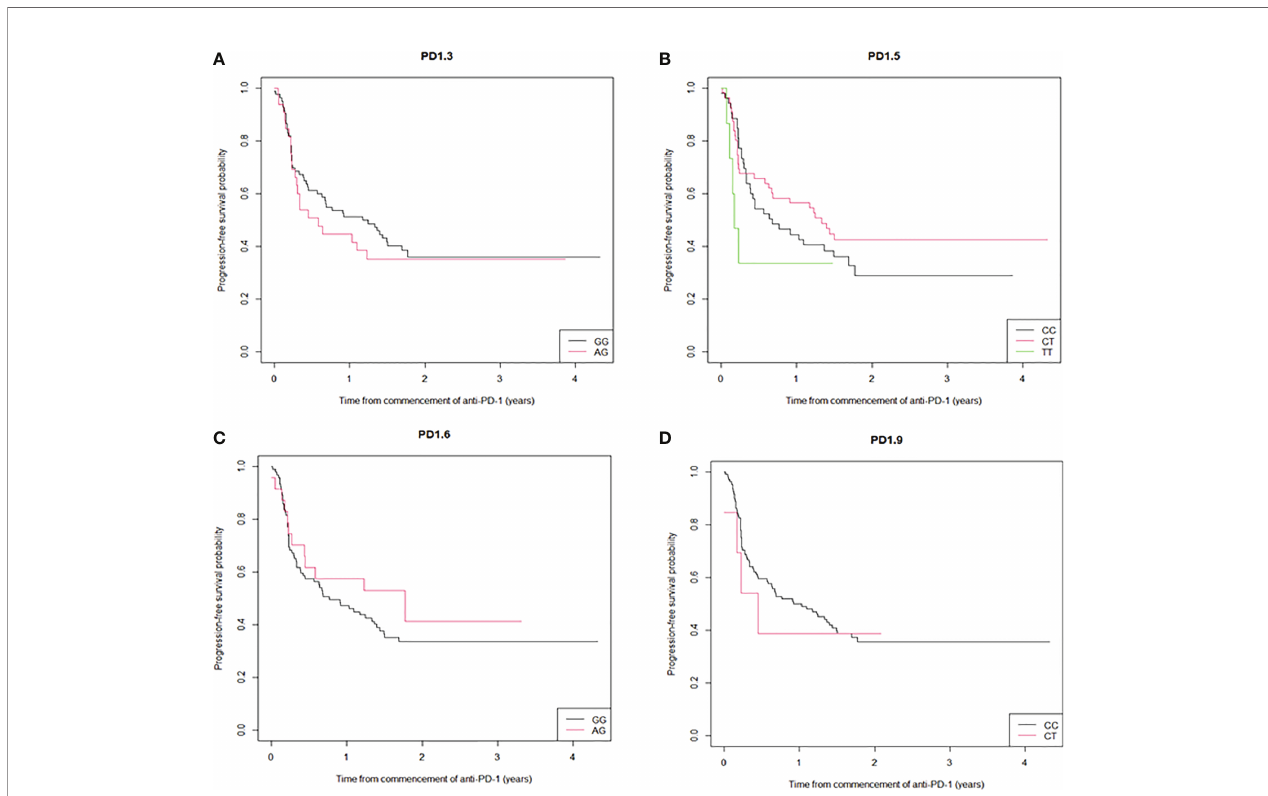
FIGURE 2 | Kaplan-Meier curves of progression-free survival strati fi ed by the individual SNPs. (A) the median PFS for PD1.3 rs11568821 GG allele was 14.1 months versus 7.0 months for the AG allele (HR 0.836 (95%CI (0.50-1.39) p=0.49); (B) the median PFS for PD1.5 rs2227981 CT allele 16 months (HR 0.79 (95%CI (0.48-1.27) p=0.329), 2.1 months for the TT allele (HR 1.78 (95%CI (0.70-4.57) p=0.228) versus 8.1 months for the CC allele; (C) the median PFS for PD1.6 rs10204525 21.3 months for the AG allele versus 9.2 months for the GG allele (HR 0.75 (95%CI (0.40-1.40) p=0.364); (D) the median PFS for PD1.9 rs2227982 CC allele was 11.0 months versus 5.4 months for the CT allele (HR 0.73 (95%CI (0.27-2.01)